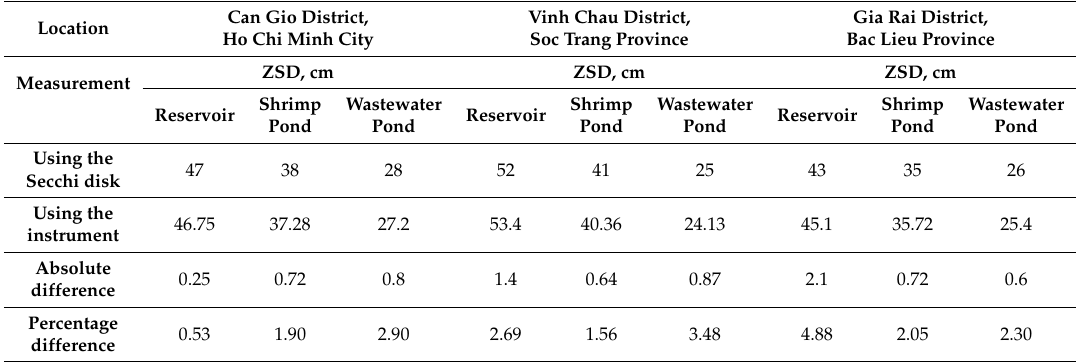
Table 2. Secchi depth measured by the Secchi disk and our instrument in HCM City, Soc Trang, and Bac Lieu provinces.